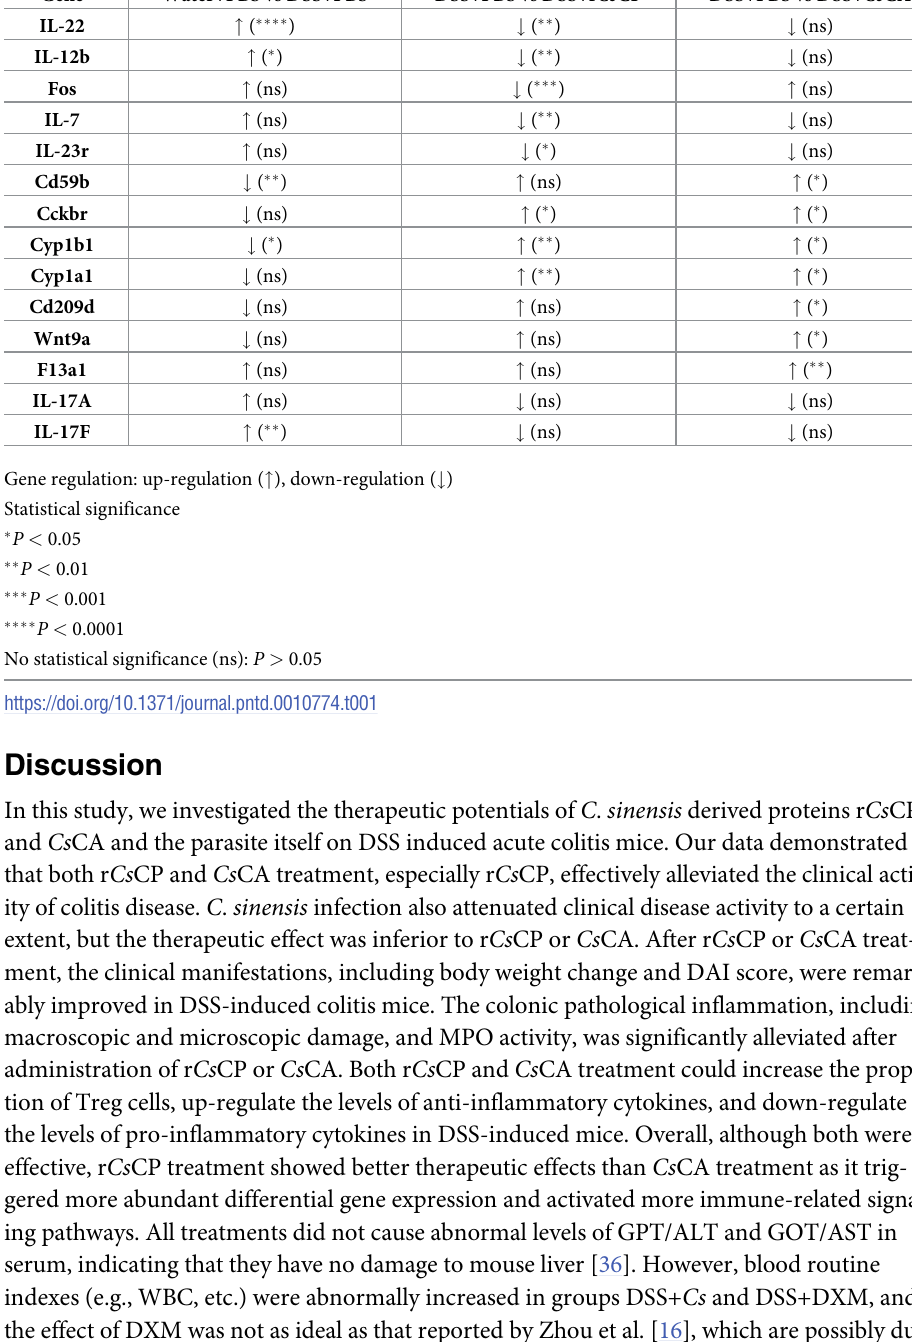
Table 1. Colonic differential gene expression in r Cs CP or Cs CA-regulated colitis mice.